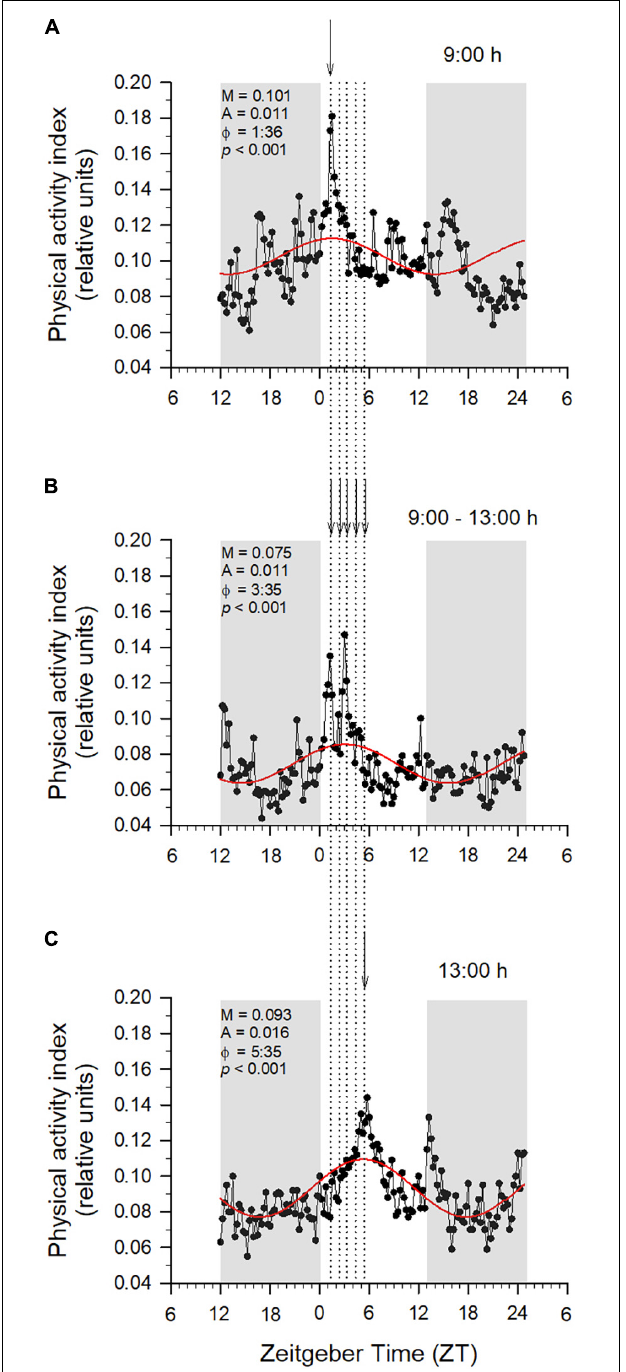
FIGURE 4 | Gilthead sea bream (mean body weight 305 g) activity synchronization by feeding with different schedules: 9:00 h (A) , once per hour between 9:00 and 13:00 h (B) , and at 13:00 h (C) . In each panel, the best-fit curve derived from cosinor analysis of physical activity AEFishBIT data (measures taken every 15 min along 2 days) of representative individuals is shown as a continuous solid line. Values of mesor (M), amplitude (A), acrophase ( φ ), and p -value (P) of best-fit curves are shown. Gray shaded areas represent dark phases. Arrows in vertical dotted lines indicates the mealtimes.